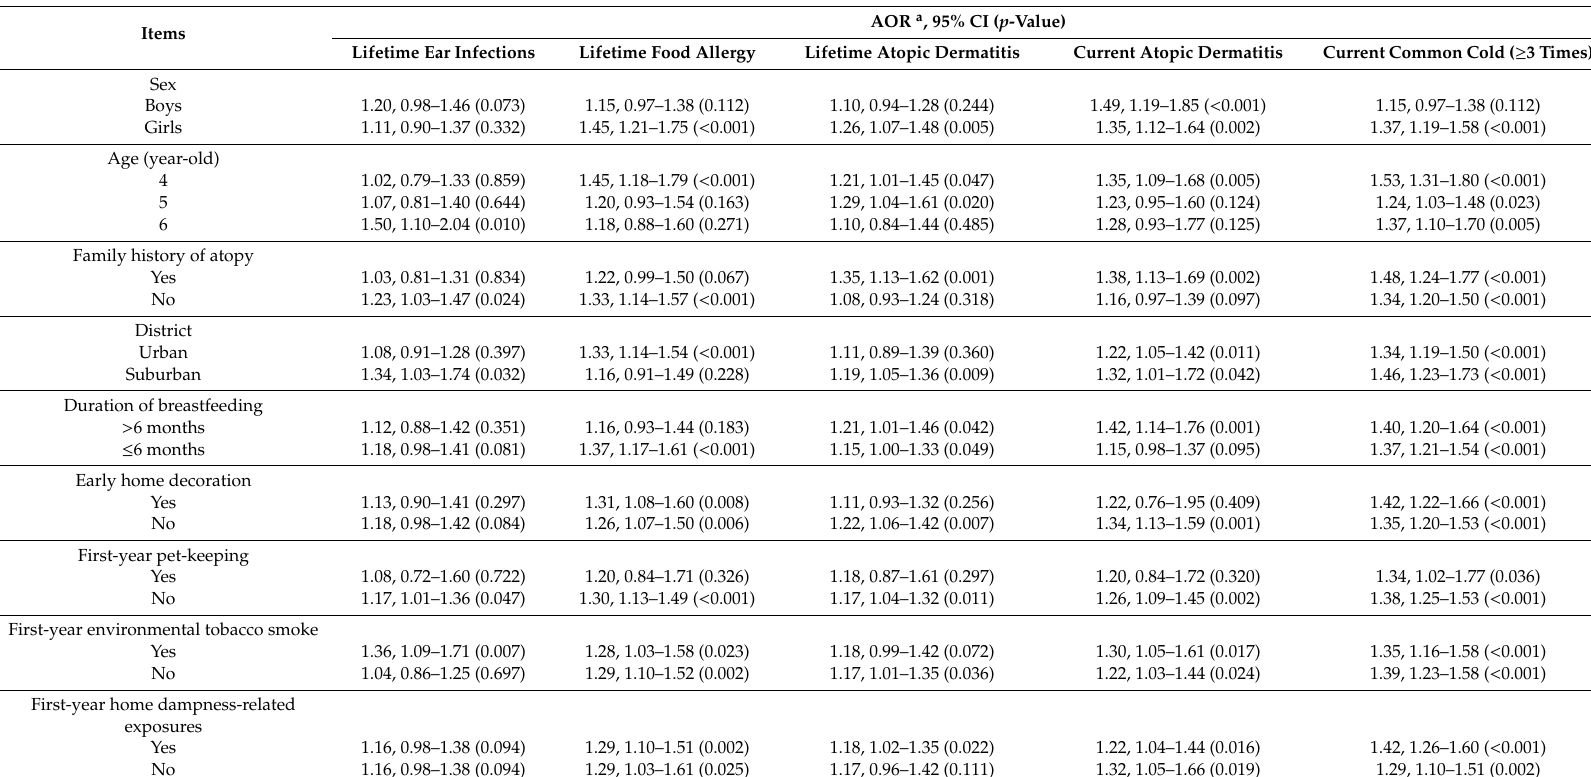
Table 8. Associations of first-year antibiotics exposure with ear infections, food allergy, atopic dermatitis, and common cold in